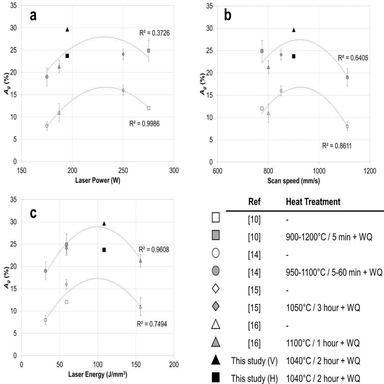
LPBF DSS 2205 uniform elongation against key process parameters (a) laser power (b) scan speed and (c) laser energy. Including data obtained from this study and available literature 14–.